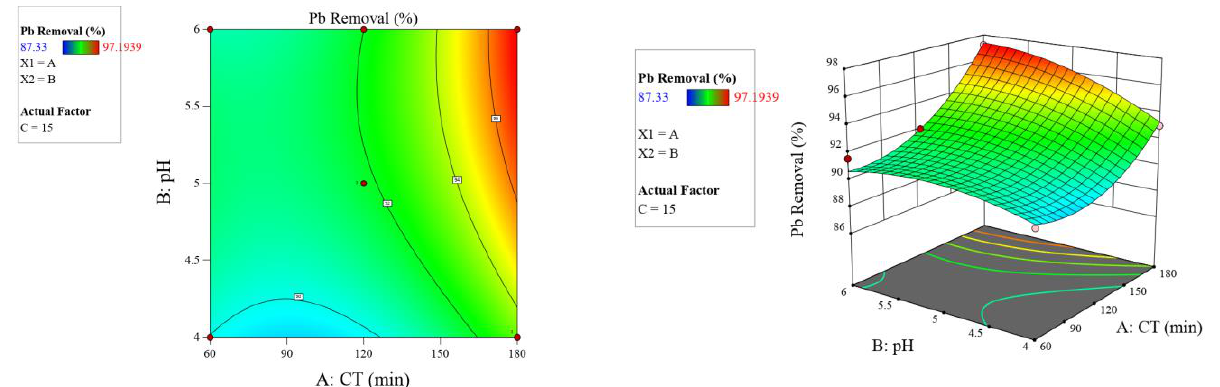
Figure 4. Residual plots: ( a ) normal probability, ( b ) predicted versus actual for removal of lead by Odaracha.